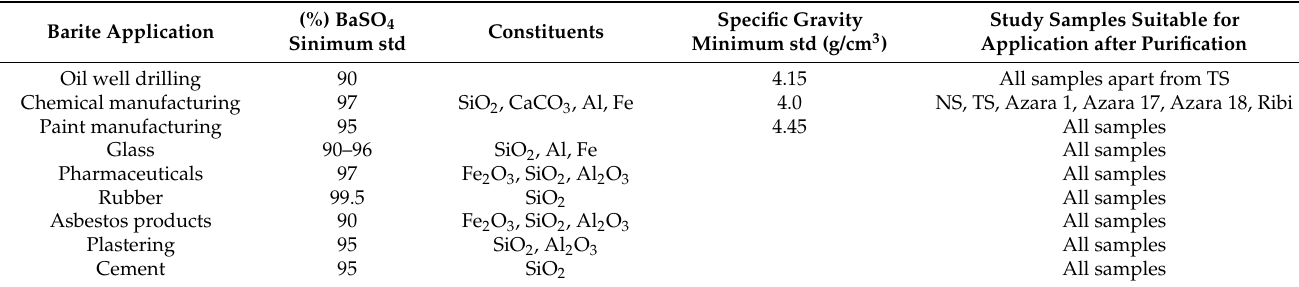
Table 4. American Petroleum Institute (API) and American Society for Testing and Materials (ASTM) general specification standards for various uses of barite ores for different industrial applications. (%) BaSO 4 Barite Application Sinimum std Oil well